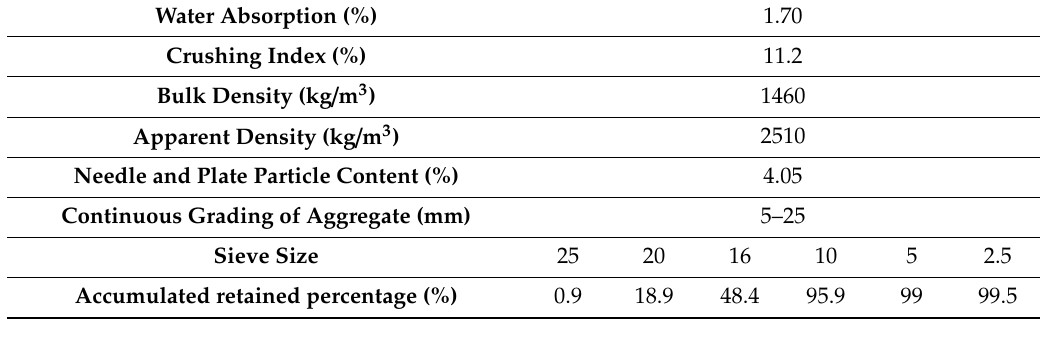
Table 2. Physical results and particle size distribution of coarse aggregate (granite stone).